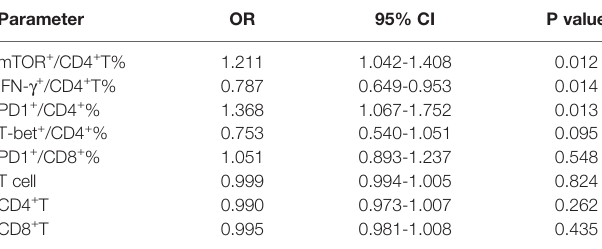
TABLE 3 | Multivariable logistic regression analysis on 28-day mortality. Parameter